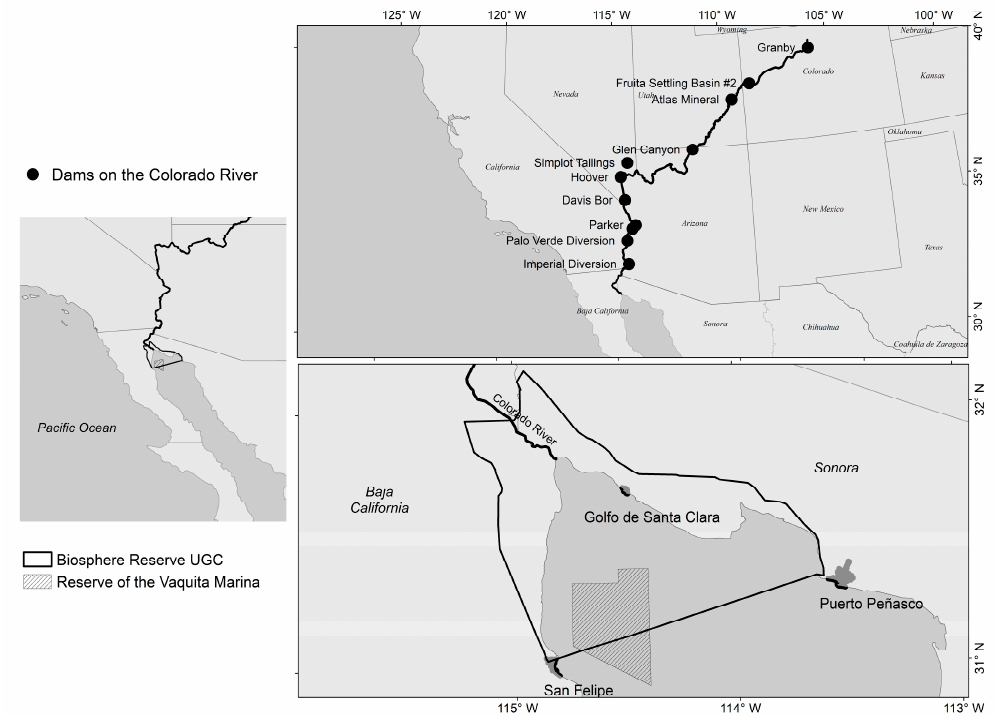
Figure 1. Study area location, Upper Gulf of California and Colorado River Delta (Baja California, Mexico). Tide stations used in this study were located in Golfo de Santa Clara, San Felipe and Puerto Peñasco coastal towns. The Biosphere Reserve and the Vaquita marina refuge polygons are